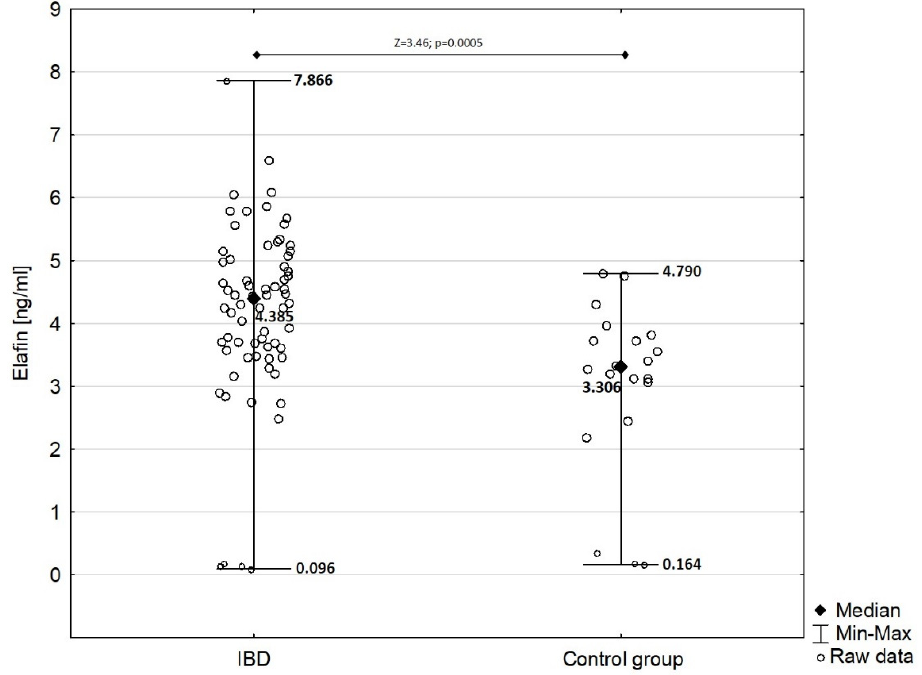
Figure 1. Comparison of serum elafin between children with IBD and children from control group.